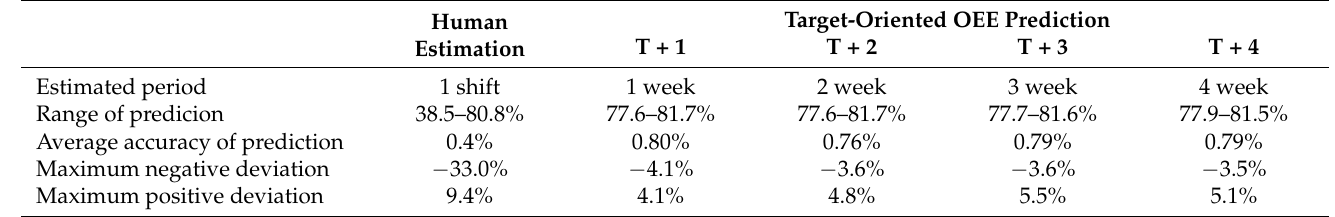
Table 8. Comparison of OEE estimation by human and target-oriented OEE